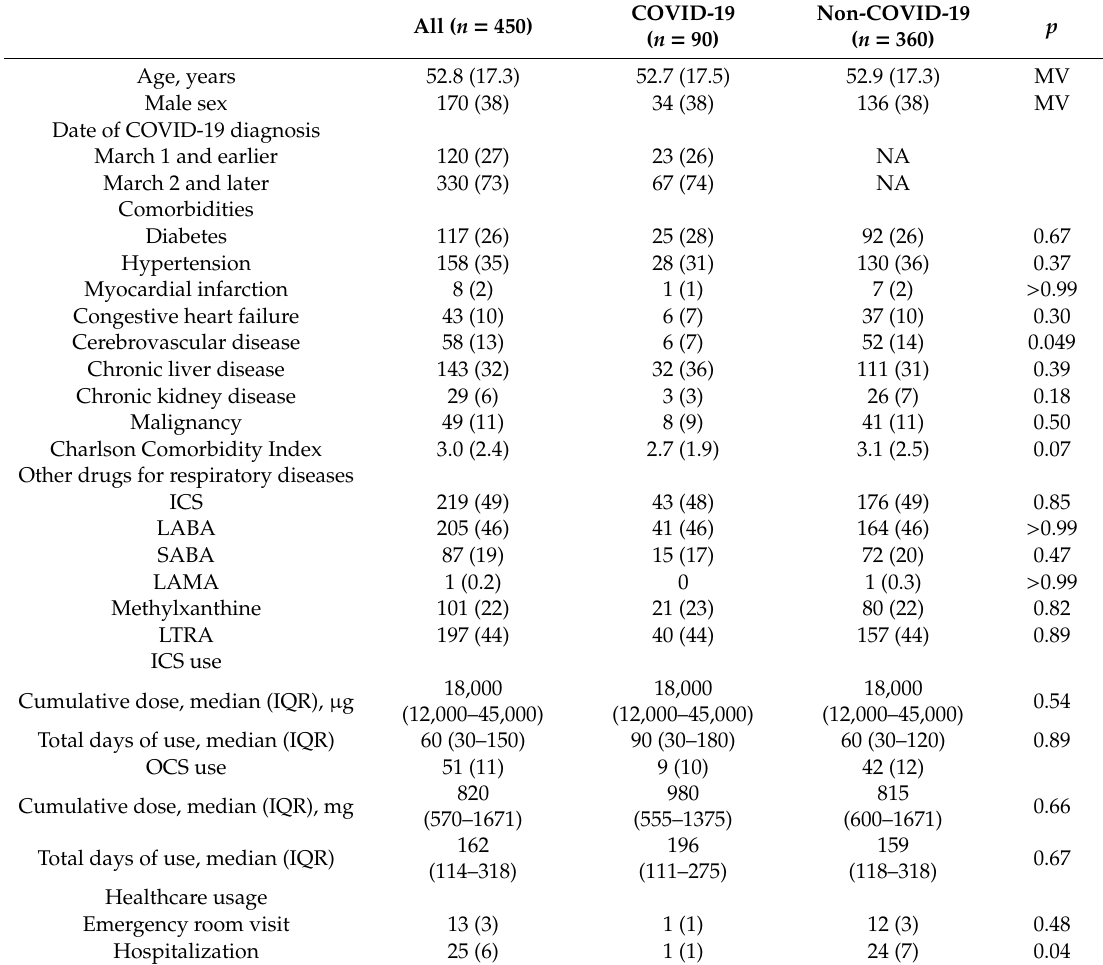
Table 4. Baseline characteristics of asthma patients with COVID-19 and matched controls.